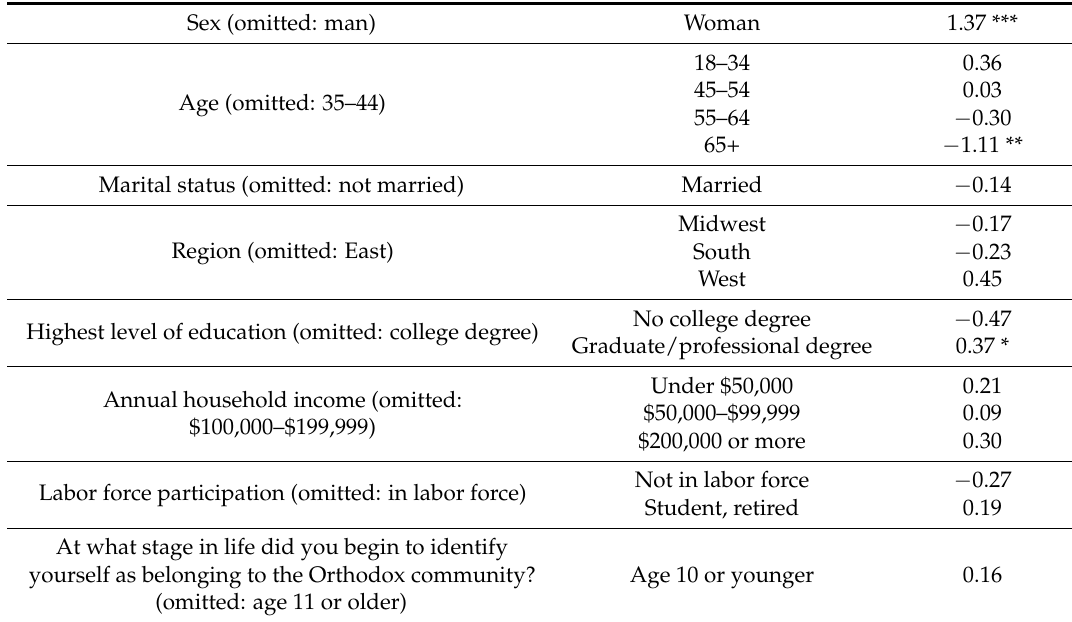
Table 4. Logistic regression of experiencing cognitive dissonance on sociodemographic characteristics